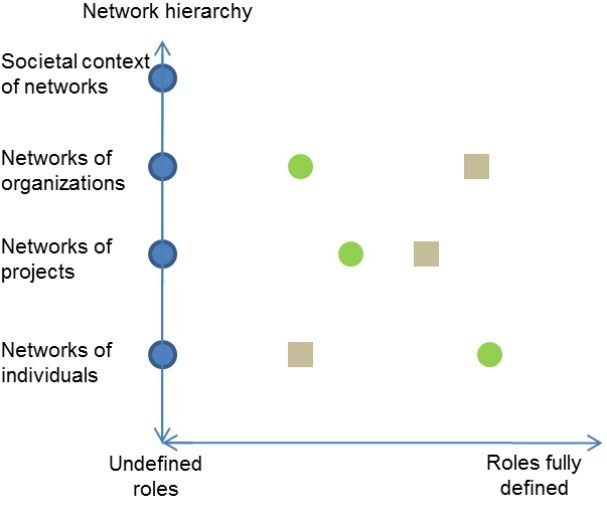
Fig. 7 . A continuous polar scale for role definition set against a network hierarchy with two